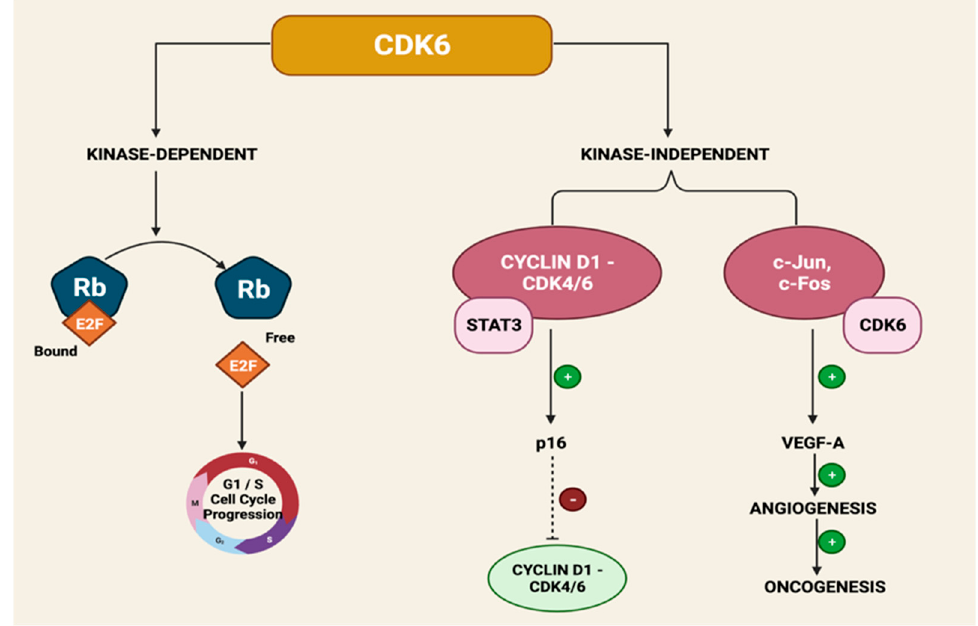
Figure 4. Mechanism of CDK6 Amplification in Resistance to CDK4/6 Inhibitors.